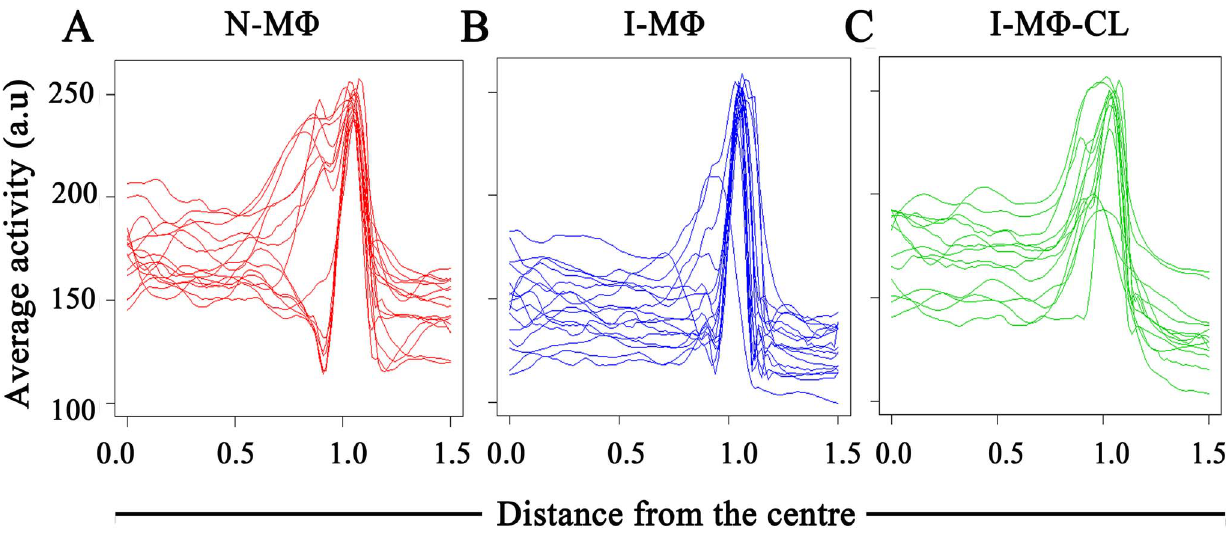
Figure 3. Analysis of PLC d 1 expression. RAW264.7 cells were transfected with plc d 1-gfp plasmid. Average expressions (activity) of the PLC d 1-GFP were measured by computational analysis as a function of distance from center of cell. Each line represents a particular cell. Activity is on a scale of 0– 255 (arbitary unit, a.u.). A) N-M W ; B) I-M W ; and C) I-M W -CL.